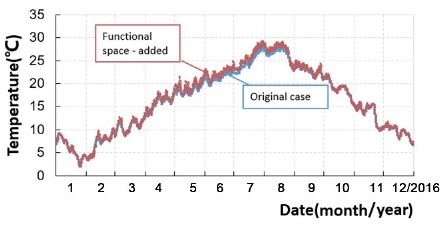
Figure 10. Point 1—temperature change.